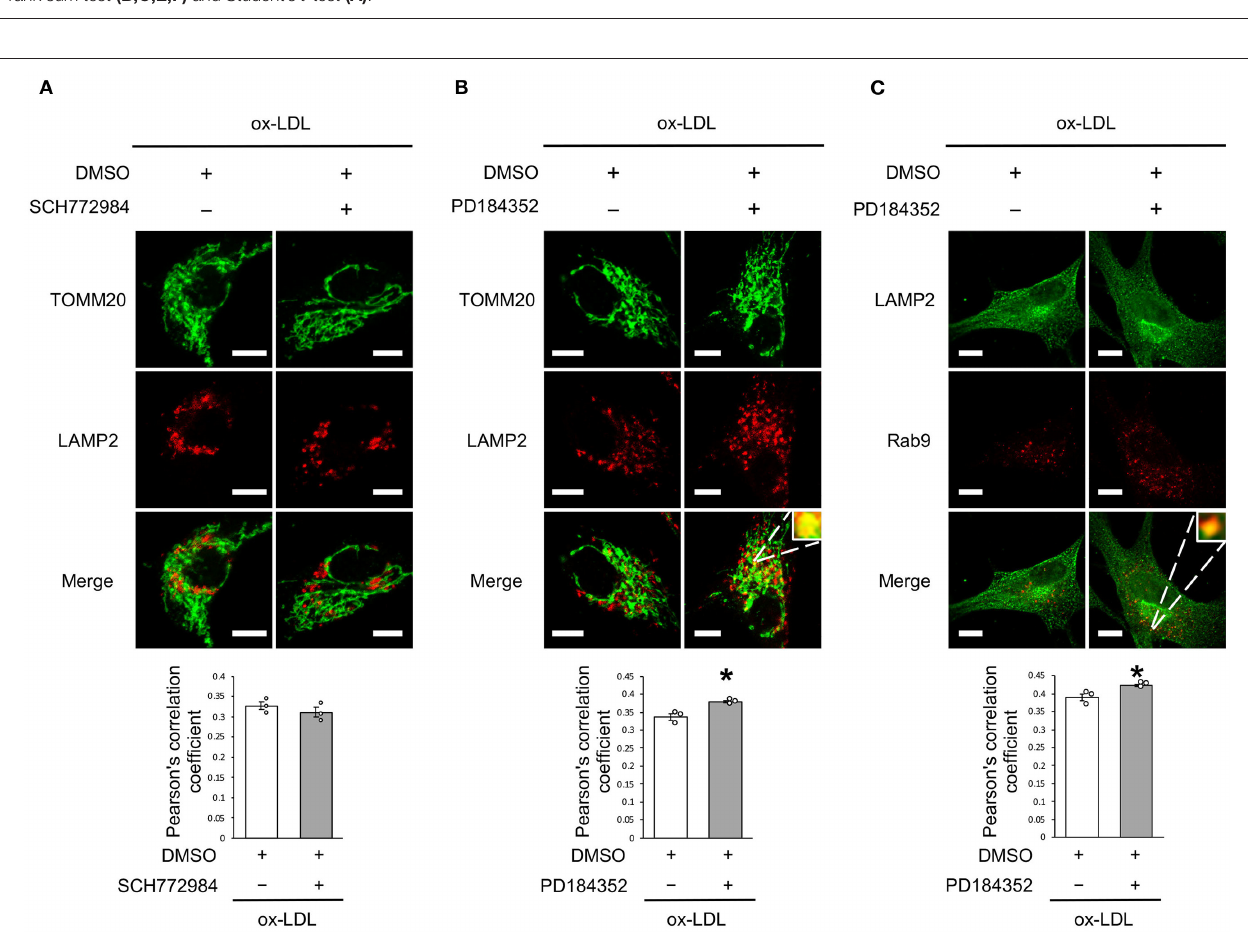
FIGURE 6 | Rab9-dependent mitochondrial autophagy was not affected by ERK inhibition but was affected by MEK inhibition. (A) Representative images and quantitative analysis of TOMM20 (green) and LAMP2 (red) immunohistochemistry in SCH772984-treated vs. control vehicle-treated cells with ox-LDL. Scale bar = 10 µ m. ( n = 3 per group). (B) Representative images and quantitative analysis of TOMM20 (green) and LAMP2 (red) immunohistochemistry in PD184352-treated vs. control vehicle-treated cells with ox-LDL. Scale bar = 10 µ m. * P < 0.05 when compared with ox-LDL with the control ( n = 3 per group). (C) Representative images and quantitative analysis of LAMP2 (green) and Rab9 (red) immunohistochemistry in PD184352-treated vs. control cells with ox-LDL. Scale bar = 10 µ m. * P < 0.05 when compared with ox-LDL with the control ( n = 3 per group). All data are presented as the mean ± SEM. Statistical analysis were conducted by Wilcoxon rank sum test (A-C)